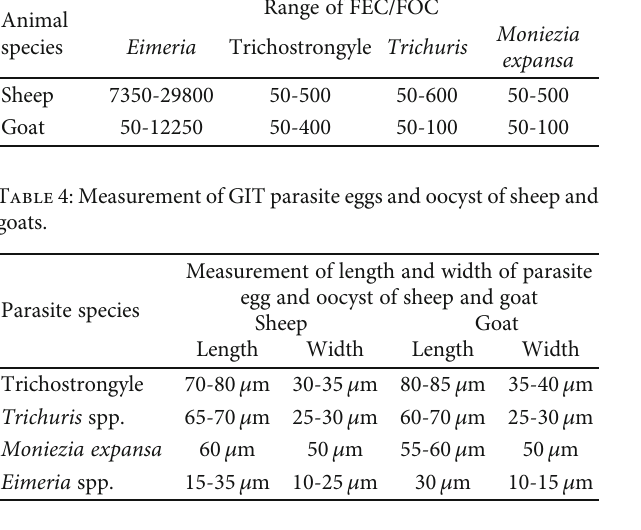
Table 3: Faecal eggs and oocyst counts (FEC/FOC) from sheep and goats. Animal